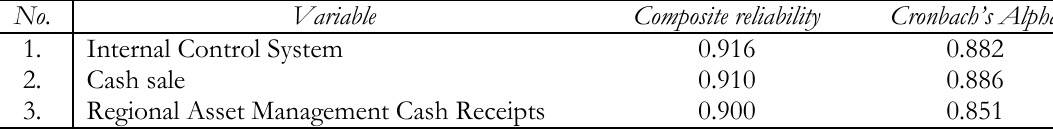
Test Results Composite